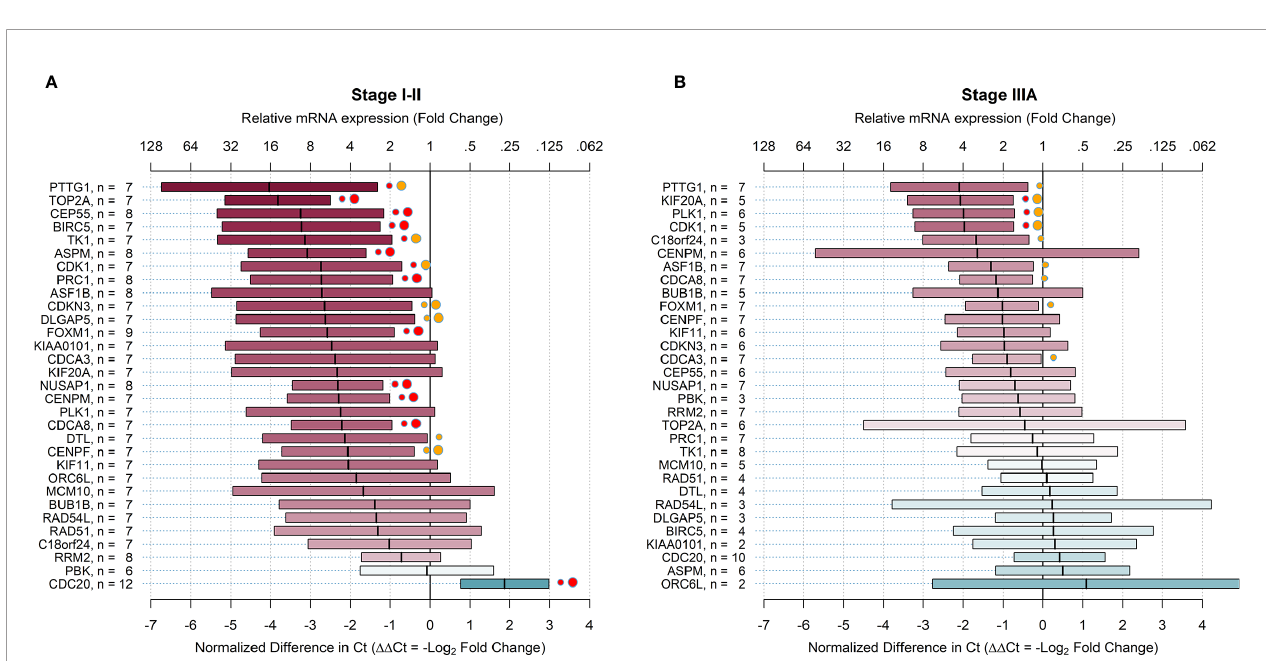
FIGURE 2 | Relative mRNA expression of target genes in ALDH high cells compared to ALDH low cells in early and advanced stages of non-small cell lung cancer. The plots show relative mRNA expression measures of 31 recurrence genes, comparing ALDH high to ALDH low cells populations. The red color of boxes indicates a higher expression in ALDH high cells, whereas the blue color indicates a higher expression in ALDH low cells. (A) early NSCLC stages (I-II); (B) advanced NSCLC stages (IIIA). Ct = cycle thresholds. DD Ct = Delta Delta Ct (normalized difference in Ct). The mid-points of the boxes are the punctual estimates and the boxes represent the 95% con fi dence intervals (not adjusted for multiple comparisons). The level of statistical signi fi cance is reported as red (p < 0.01) or orange (p < 0.05) circles next to the boxes. Small circles represent raw p-values, whereas large circles represent Benjamini-Hochberg-corrected p-values (i.e. with false discovery rate (FDR) correction). There were 16 (51.6%) target genes that were signi fi cantly overexpressed in the early stages and 9 (29.0%) genes signi fi cantly overexpressed in the advanced stages of NSCLC. When the FDR correction was applied for multiple comparisons, the number of overexpressed genes declined to 15 (48.4%) in early stages and 3 (9.7%) in advanced stages.